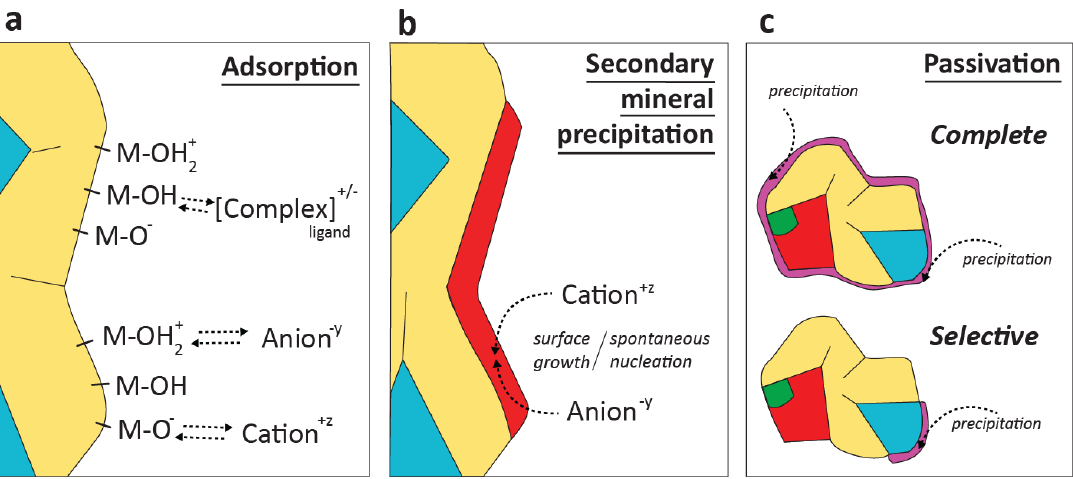
Figure 2. Schematic of key geochemical attenuation processes in mine waste rock: adsorption ( a ) and secondary mineral formation ( b ). Through adsorption, (hydrated) ionic or ligated solutes and complexes adsorb to mineral surface groups (-M-(x)) through covalent bonding or electrostatic interaction. Secondary minerals form on mineral surfaces or spontaneously in solution through (co-)precipitation of cationic and anionic aqueous solutes. The occlusion of mineral surfaces by secondary mineral precipitation is referred to as passivation or armoring ( c ), discussed in Section 2.5.